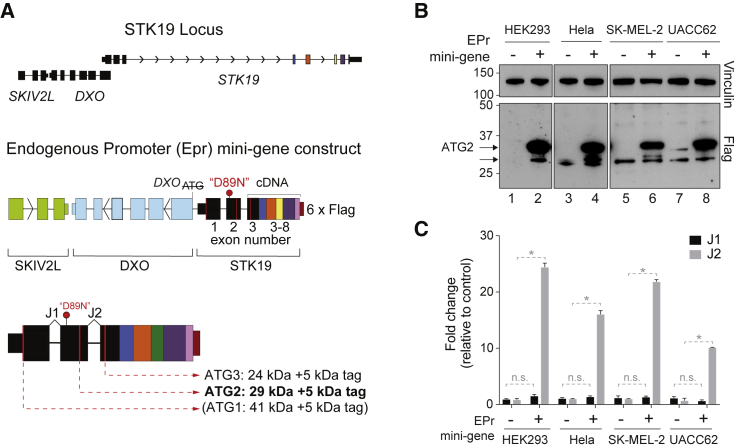
Multi-copy Overexpression of STK19 from Its Endogenous Promoter(A) Schematic representation of the endogenous promoter (EPr) system created to assess STK19 protein isoform expression. The upstream region of STK19, encompassing the end of the SKIV2L gene and the entire DXO gene, as well as the first 2 exons and 2 introns (following the current annotation) were fused with cDNA encoding exons 3 to 8. Since the STK19 promoter may overlap with the upstream DXO gene, the ATG of this gene was mutated to avoid DXO protein expression. Sequence encoding a 2x triple-FLAG tag was inserted at the 3′ end of the construct. Exon numbers and the location of the “D89N” mutation are shown. Schematic representation of STK19 isoforms that could conceivable be expressed are shown below.(B) Western blot of whole cell extract of the transient transfection of the EPr construct, compared to empty vector in the indicated cell lines. Arrows indicate the expressed isoforms. Bands at 34 and 29 kDa correspond to expression from the 2nd and 3rd ATG (or possibly a degradation product), respectively.(C) qPCR of STK19 expression after transient EPr or empty vector transfection (relative to endogenous untransfected control and normalized to GAPDH levels) comparing exon-exon junction 1 (J1) and 2 (J2) as per the current annotation. Error bars represent ± SD. Statistically significant differences (p < 0.05, multiple t tests, Holm-Sidak correction) of three replicates are indicated with asterisks. Non-significant differences are indicated with “n.s.” when relevant.